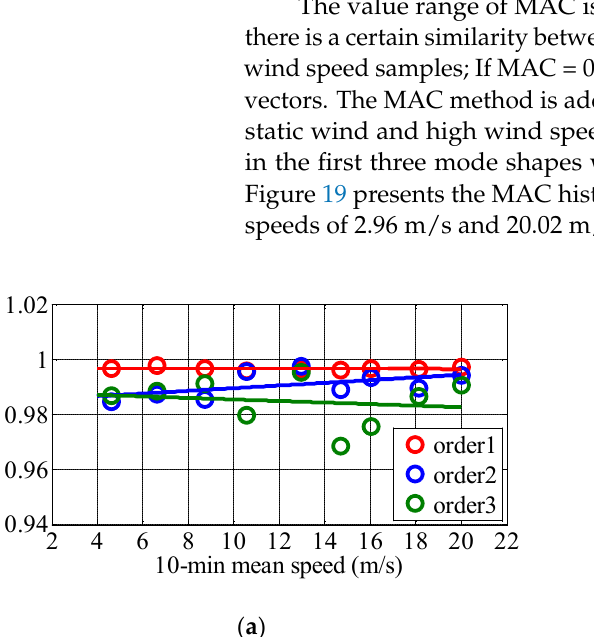
Figure 18. MAC values of measured U 10min relative to 2.96m/s in the first three mode shapes with the same order. ( a ) along x -axis; ( b ) along y -axis.